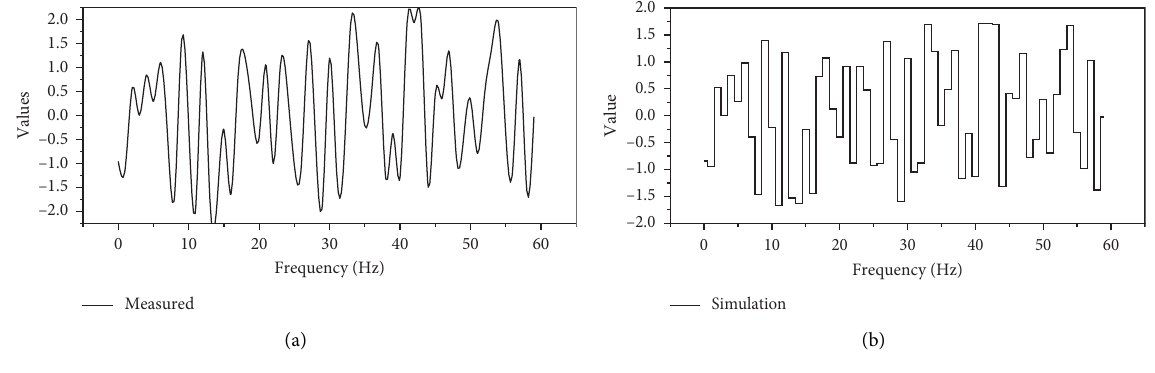
Figure 10: MIDI score quantization